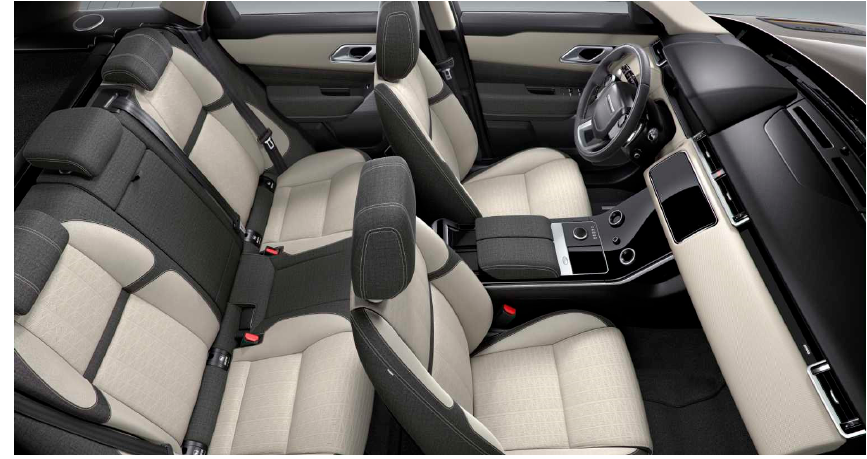
Figure 18. Car interior, reproduced from [224] under open access license.